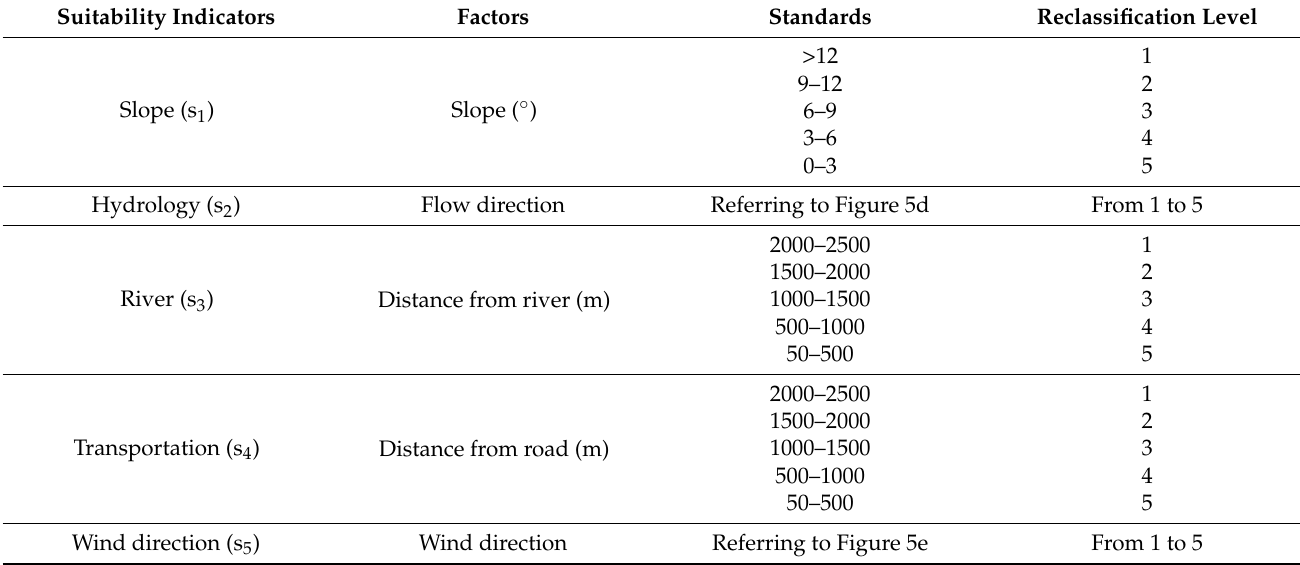
Table 2. The standards of suitability